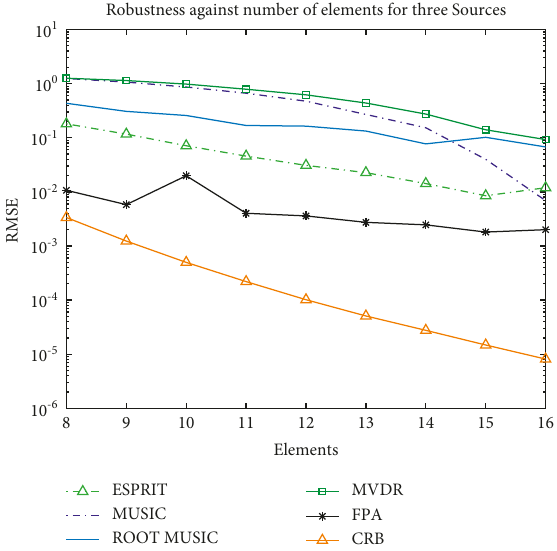
Figure 10: Robustness against the number of elements for two sources of 10dB of SNR.